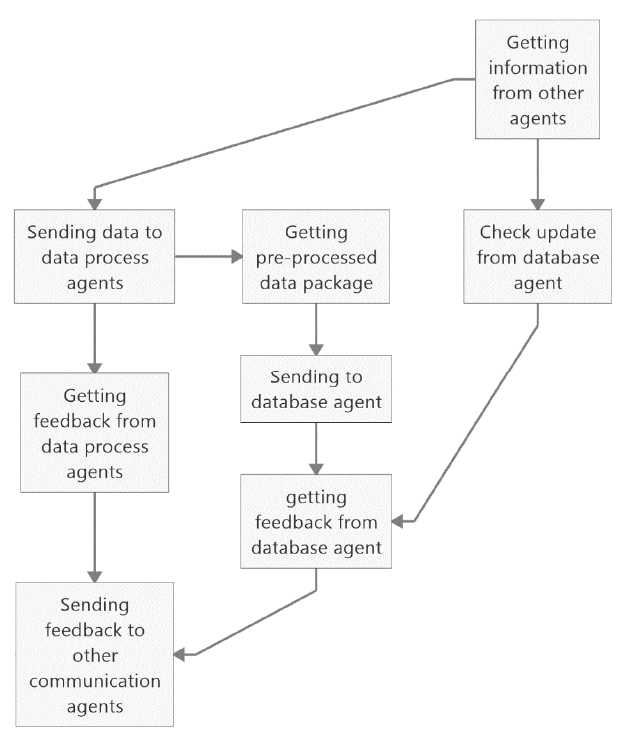
Figure 7. Communication agent for data process.